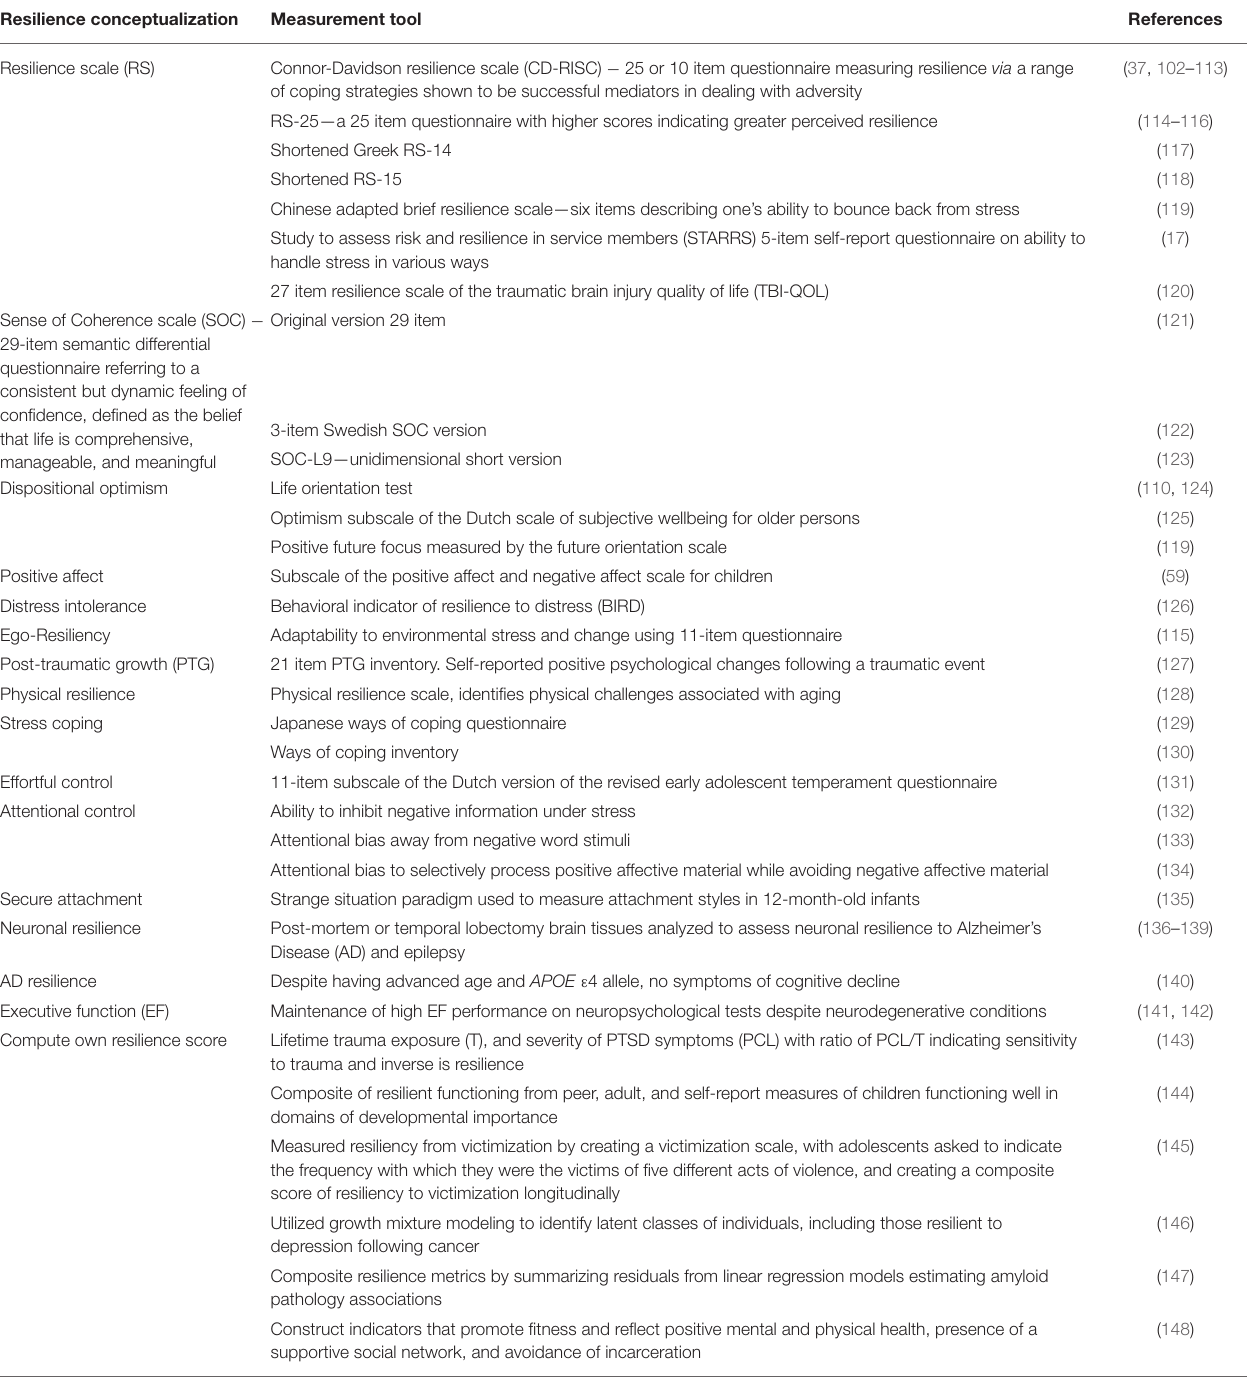
TABLE 2 | Operationalisation of resilience as a form of positive adaptation and measurement tools